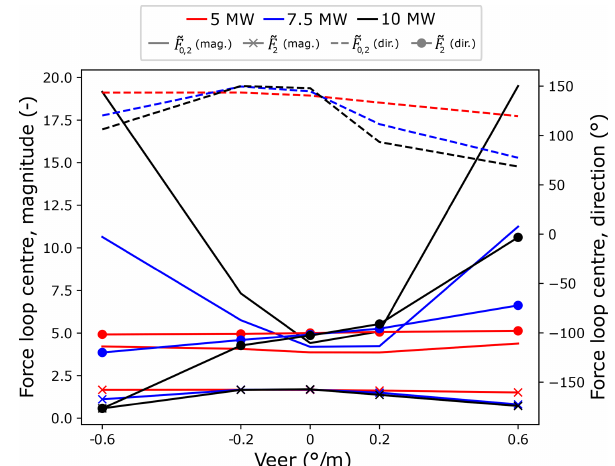
Figure C2. Non-dimensionalised, downwind-row, radial force- loop-centre magnitude and direction values for overhung ( ˜ F 0 , 2 ) and centred ( ˜ F 2 ) main-bearing configurations across the three modelled turbines as the veer gradient is varied.